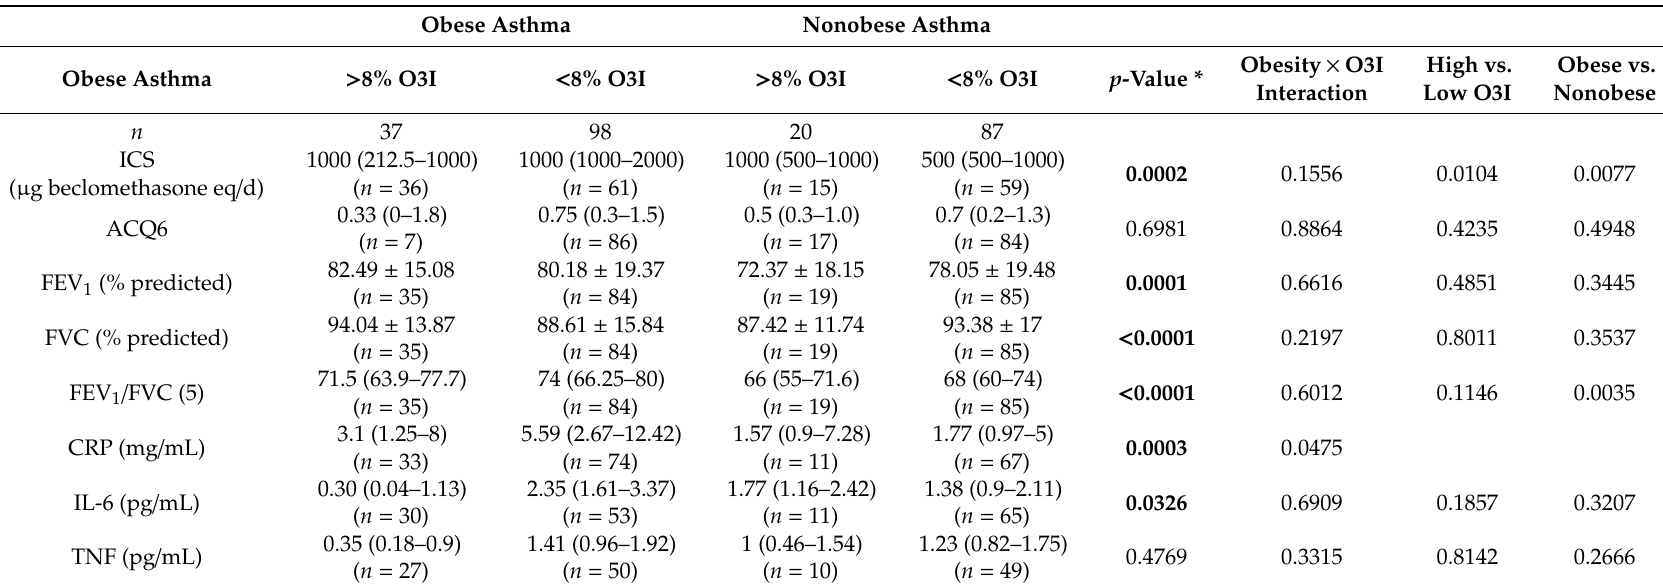
Table 3. Clinical asthma markers and inflammatory markers of subjects with asthma, classified by weight and O3I. Obese